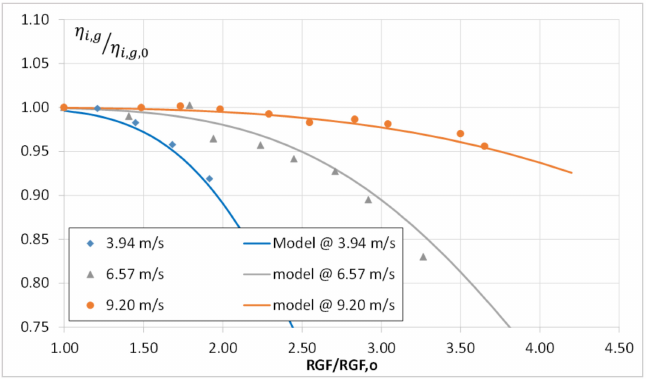
Figure 13. Variation of the engine gross indicated efficiency as a function of the RGF